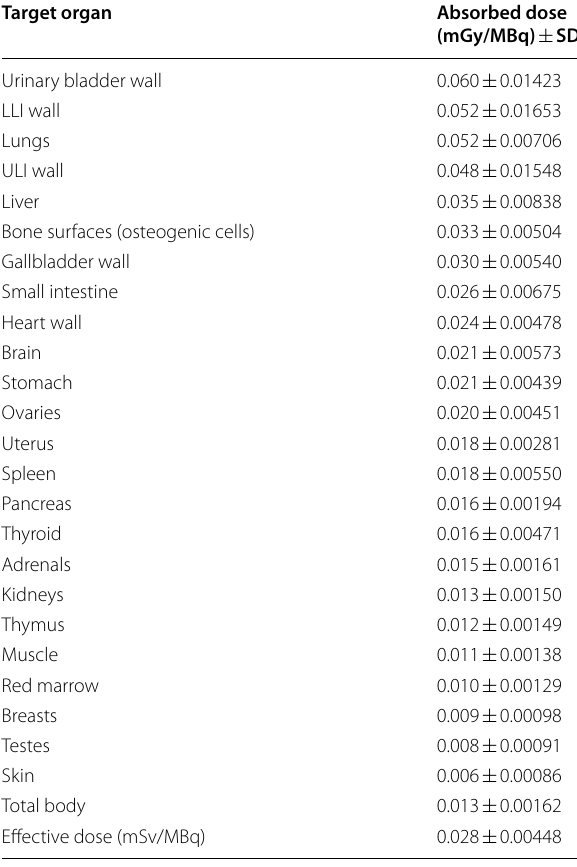
Table 4 Absorbed effective dose in Chinese HVs